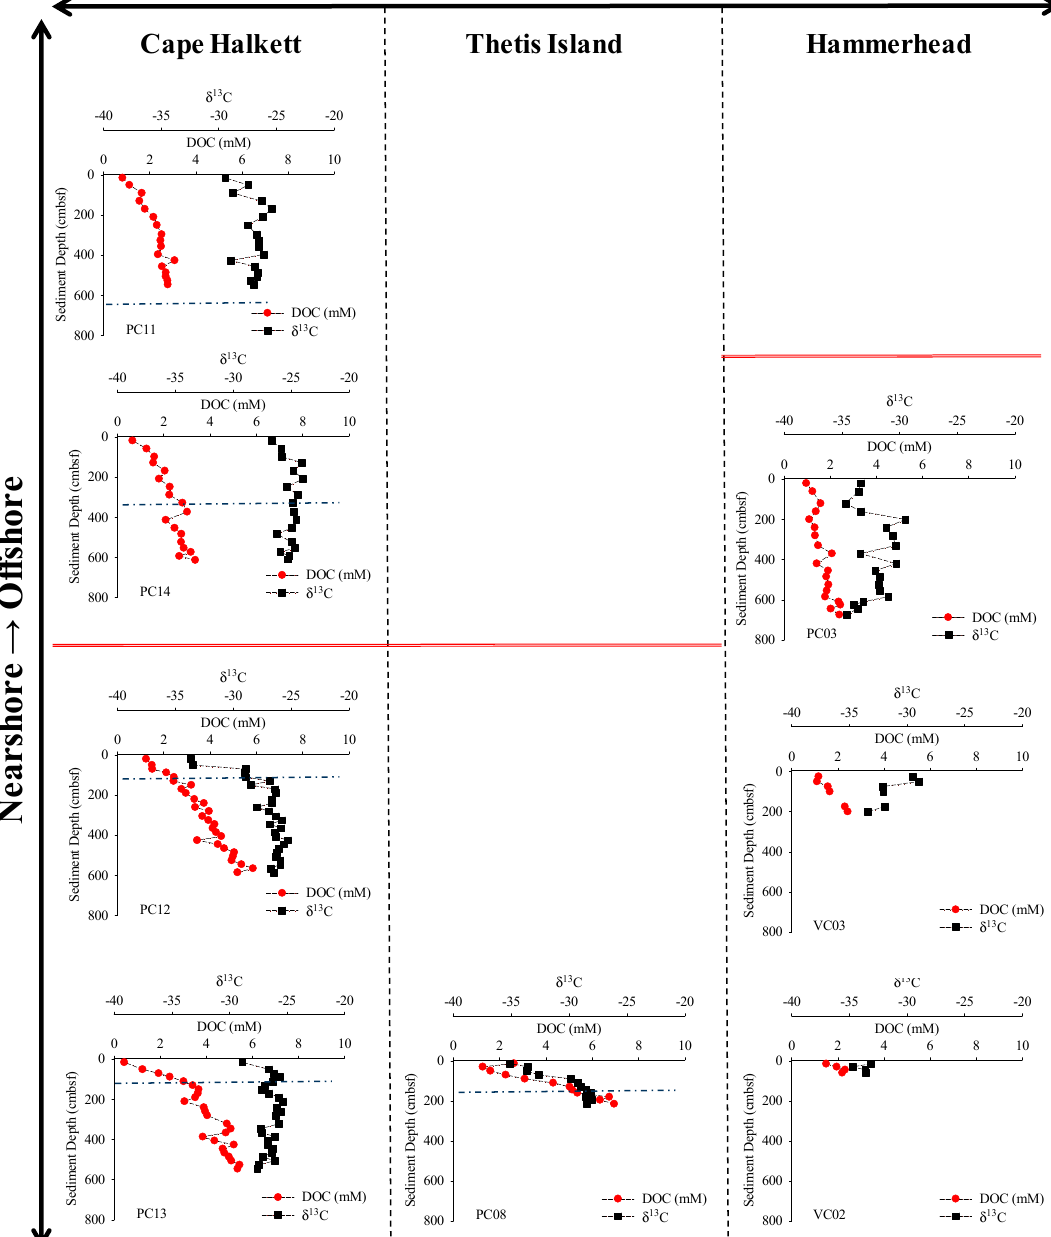
Figure 5. Porewater profiles for dissolved organic carbon (DOC) concentration (mM C) and δ 13 C DOC plotted vs. depth (cm) in the sediment below seafloor (cmbsf) for cores collected along the North Slope of Alaska on the Beaufort Sea. Core profiles are separated into three distinct sampling transects (Cape Halkett, Thetis Island and Hammerhead) and displayed by relative location west-to-east (left-to-right) and offshore-to-nearshore (top-to-bottom) on the North Slope. The blue dashed line presented in plots with a measured SMT represents the depth reported in Table 1. The red line in each transect indicates the relative location of the shelf-break for each coring transect (Figure 1). Data on DOC concentration and δ 13 C DOC values are not presented for stations Hammerhead offshore station PC09 and Thetis offshore station PC04 because sufficient porewater volumes could not be obtained during sampling. Measured porewater δ 13 C DOC values ranged from − 35.1 to − 24.0‰ (Figure 5). Hammerhead nearshore, Hammerhead offshore and Thetis Island δ 13 C DOC values were similar with values at